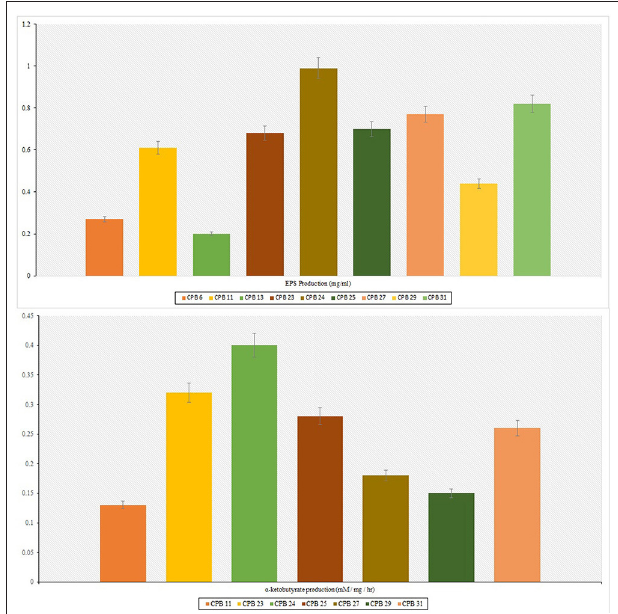
FIGURE 2 | Exopolysaccharides (EPS) and ACC deaminase production. The production of both EPS and ACC was less commonly observed; few isolates were positive for exopolysaccharides production, and very few were able to produce ACC deaminase. The isolate CPB-24 was able to produce both exopolysaccharides and ACC deaminase.